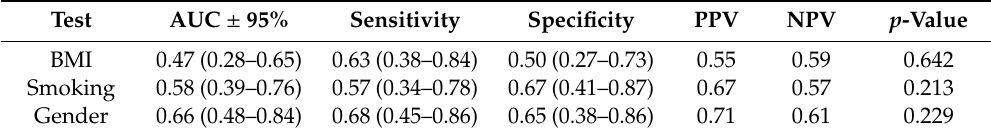
Table 6. Confounding factors: G.A.S. BreathSpec GC-IMS results.